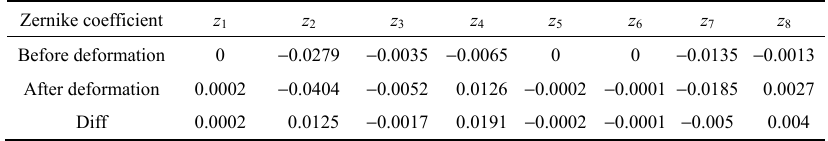
Fig. 6 Left is the opto-mechanical structure design of telescope prototype; the right is the structural deformation nephogram of the telescope prototype due to in-orbit temperature and gravity release. Table 3 Zernike coefficients of the wavefront of the telescope system before and after deformation. Zernike